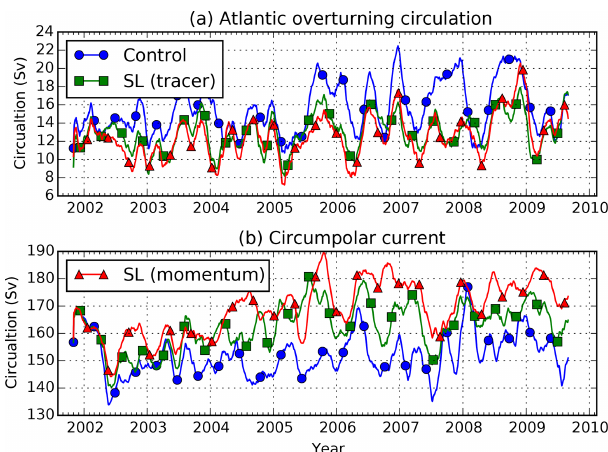
Figure 6. (a) The 61d mean transports for the Atlantic overturning circulation (net northward flux above 1000m depth at 27 . 25 ◦ N lat- itude in the Atlantic Ocean) and (b) Antarctic circumpolar current (net eastward flux at 67 . 75 ◦ W longitude in the Drake Passage) over time for the test cases of Sect.